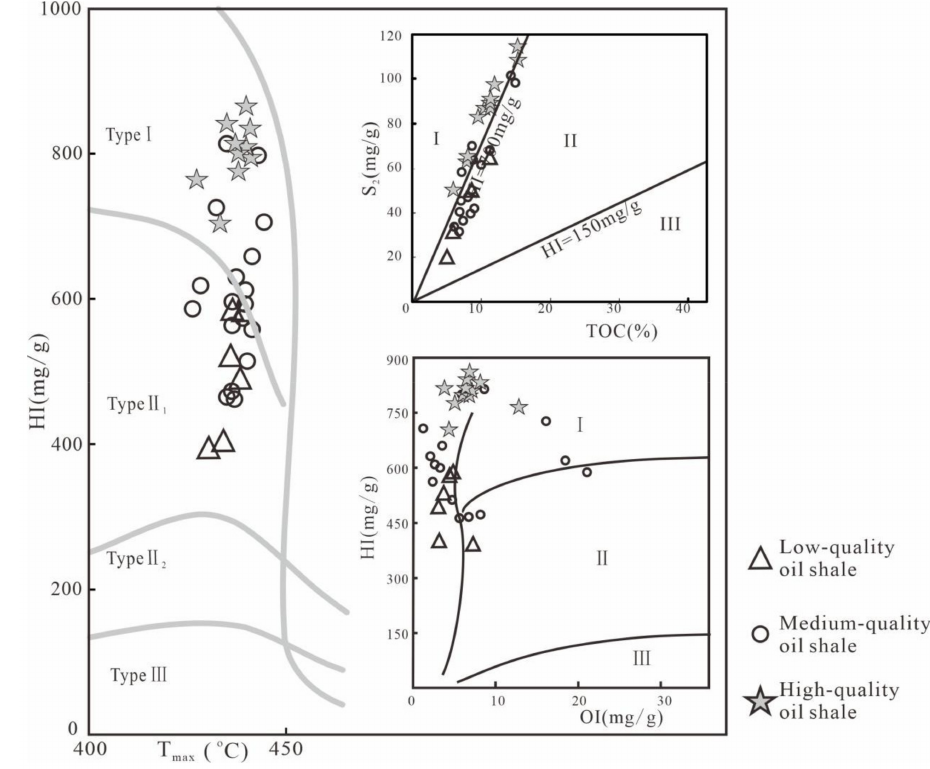
Figure 5. The organic matter type of different-quality oil shales in the Shale Member of the Shimengou Formation. Diagrams after Espitali é et al., Langford and Blanc-Valleron, and Mukhopadhyay et al.